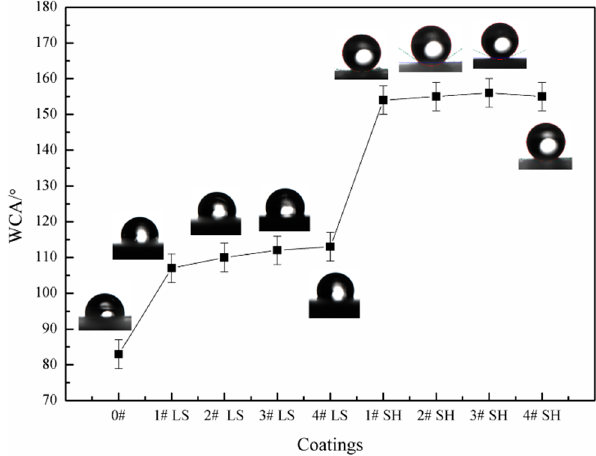
Figure 2. Water contact angles (WCAs) of the WPU composites with di ff erent M-PDMS / PTFE system contents.